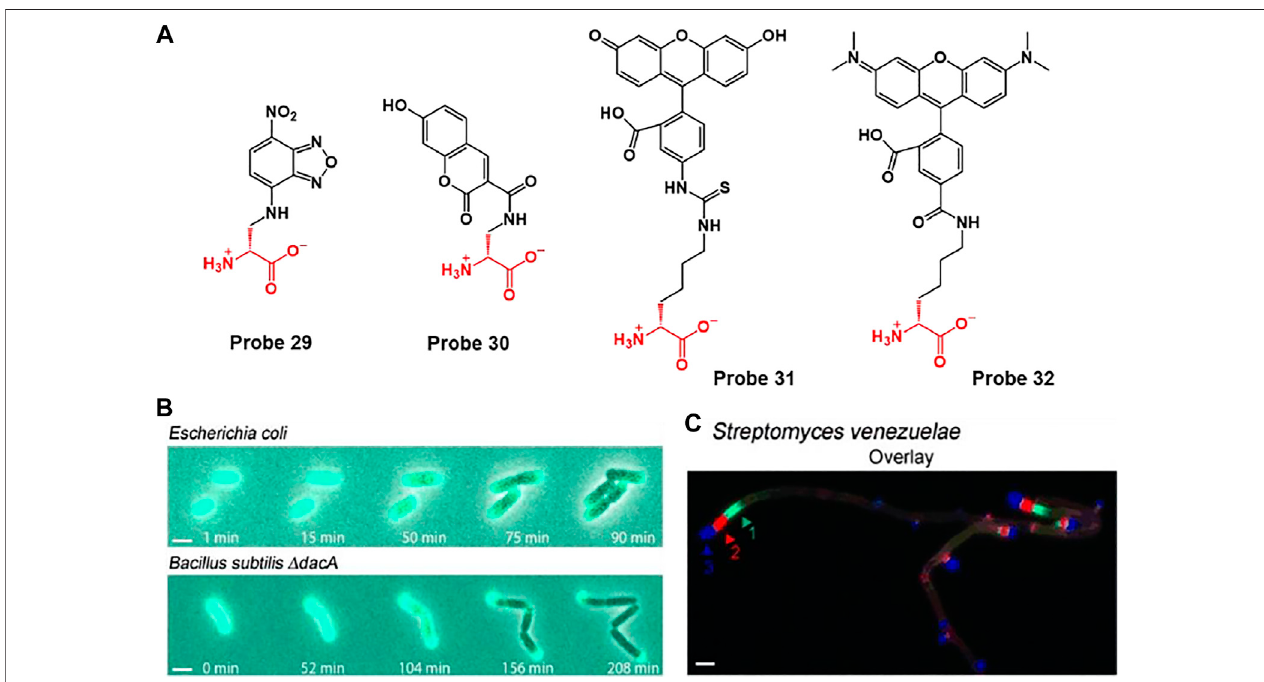
FIGURE 16 | (A) Chemical structures of probes 29 – 32. FDAAs label diverse bacterial growth patterns. (B) Time-lapse microscopy of HADA-labeled E. coli and B. subtilis Δ dacA cells imaged during growth on LB agarose pads (LB (cid:1) Luria Bertani). (C) Triple labeling of S. venezuelae with probe 29 (green), 30 (blue), and 32 (red). Arrowsinthetriple-labelingpanelsindicatethesequenceoflabeling.ReproducedwithpermissionfromKuruetal.(2012).Copyright © 2012WILEY-VCHVerlagGmbH& Co. KGaA, Weinheim.